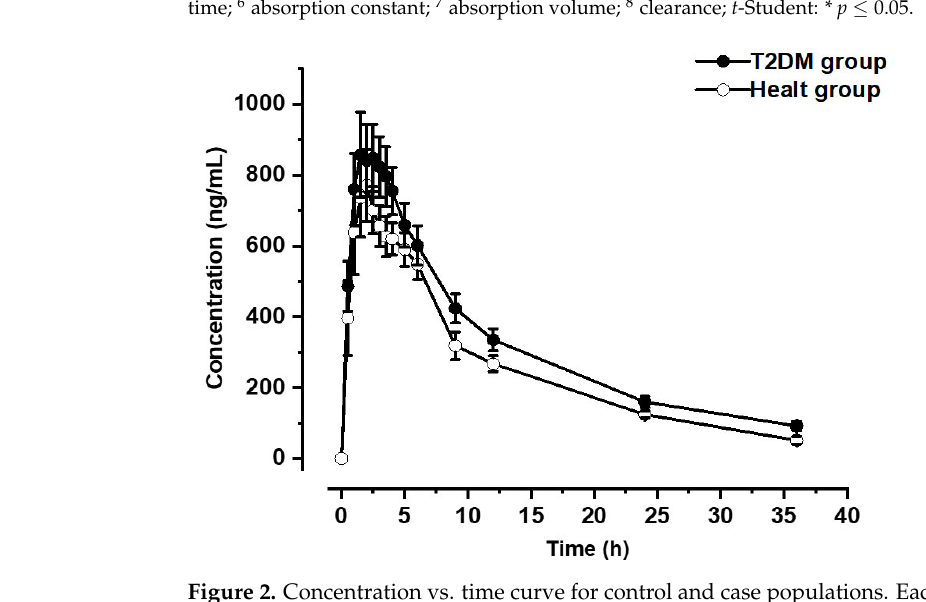
Figure 2. Concentration vs. time curve for control and case populations. Each line represents the X ± E.E. of the plasma concentration (ng/mL) of pioglitazone, after oral administration of a 30 mg tablet of pioglitazone.